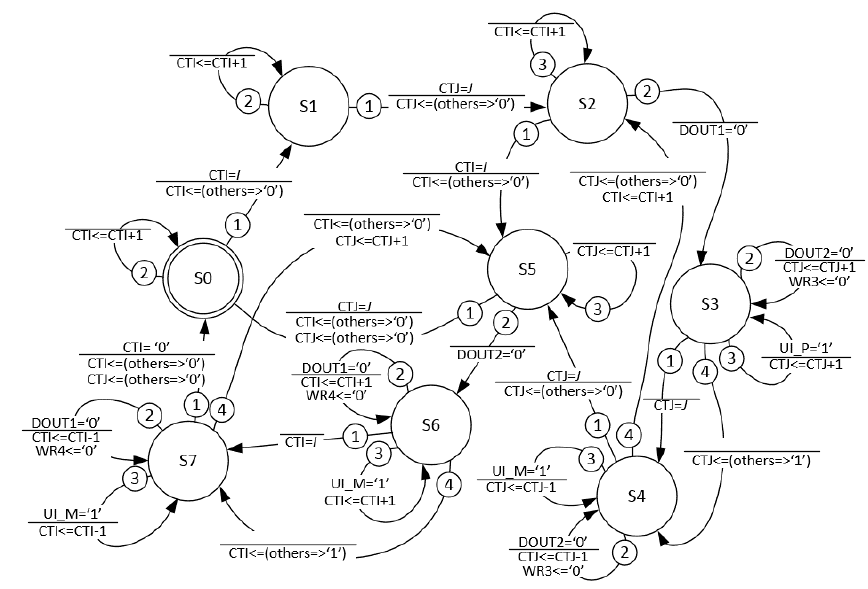
Figure 4. The finite-state machine graph, managing the work of the surface defect monitoring system.